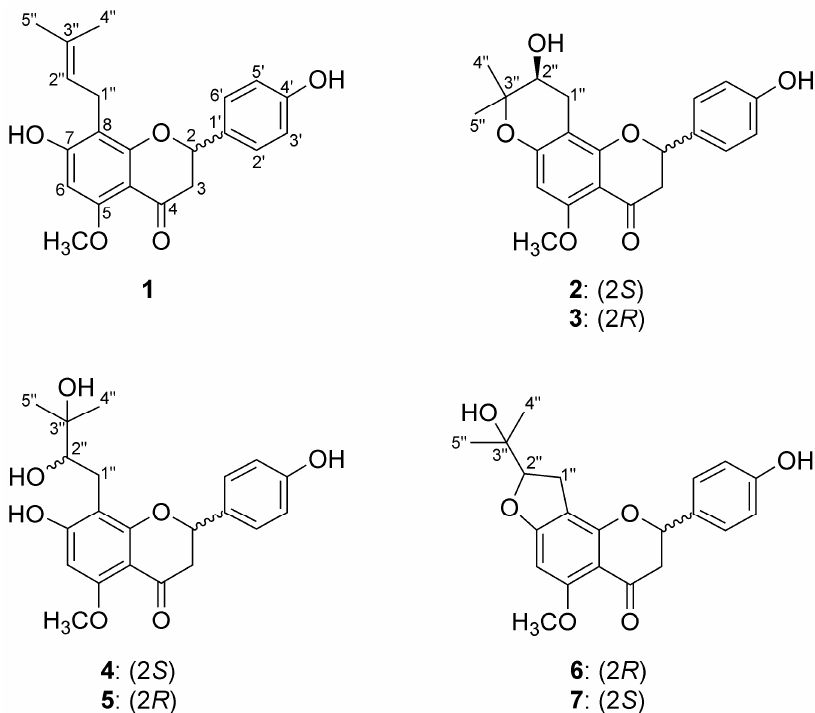
Figure 1. The structures of isoxanthohumol ( 1 ) and its metabolites ( 2 – 7 ).